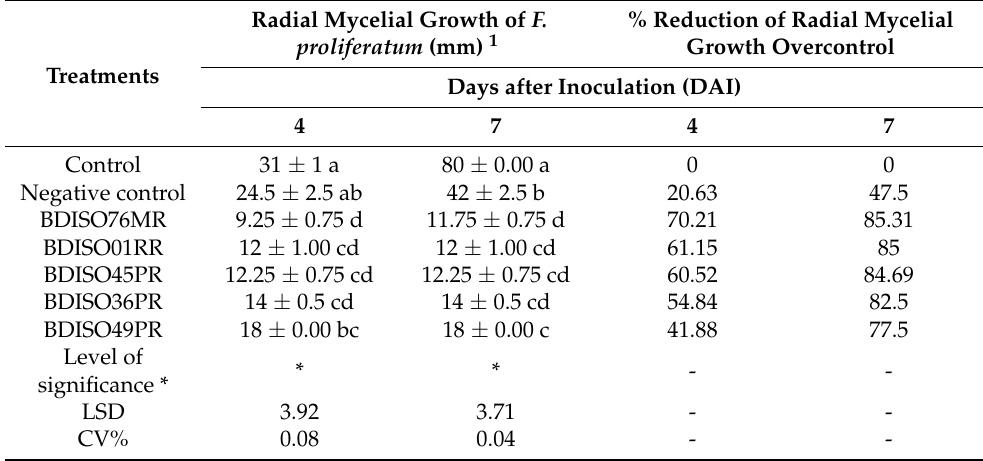
* Indicates significance at a 5% level of significance. 1 Data are the averages of three replications ± SE (standard error). Values with similar letters are statistically similar. (BDISO01RR: B. amyloliquefaciens , BDISO36PR: B. subtilis , BDISO45PR: B. subtilis , BDISO49PR: B. subtilis and BDISO76MR: B. subtilis ). Control: F. proliferatum only and Negative control: Bacillus species that could not inhibit the mycelial growth of F. proliferatum .